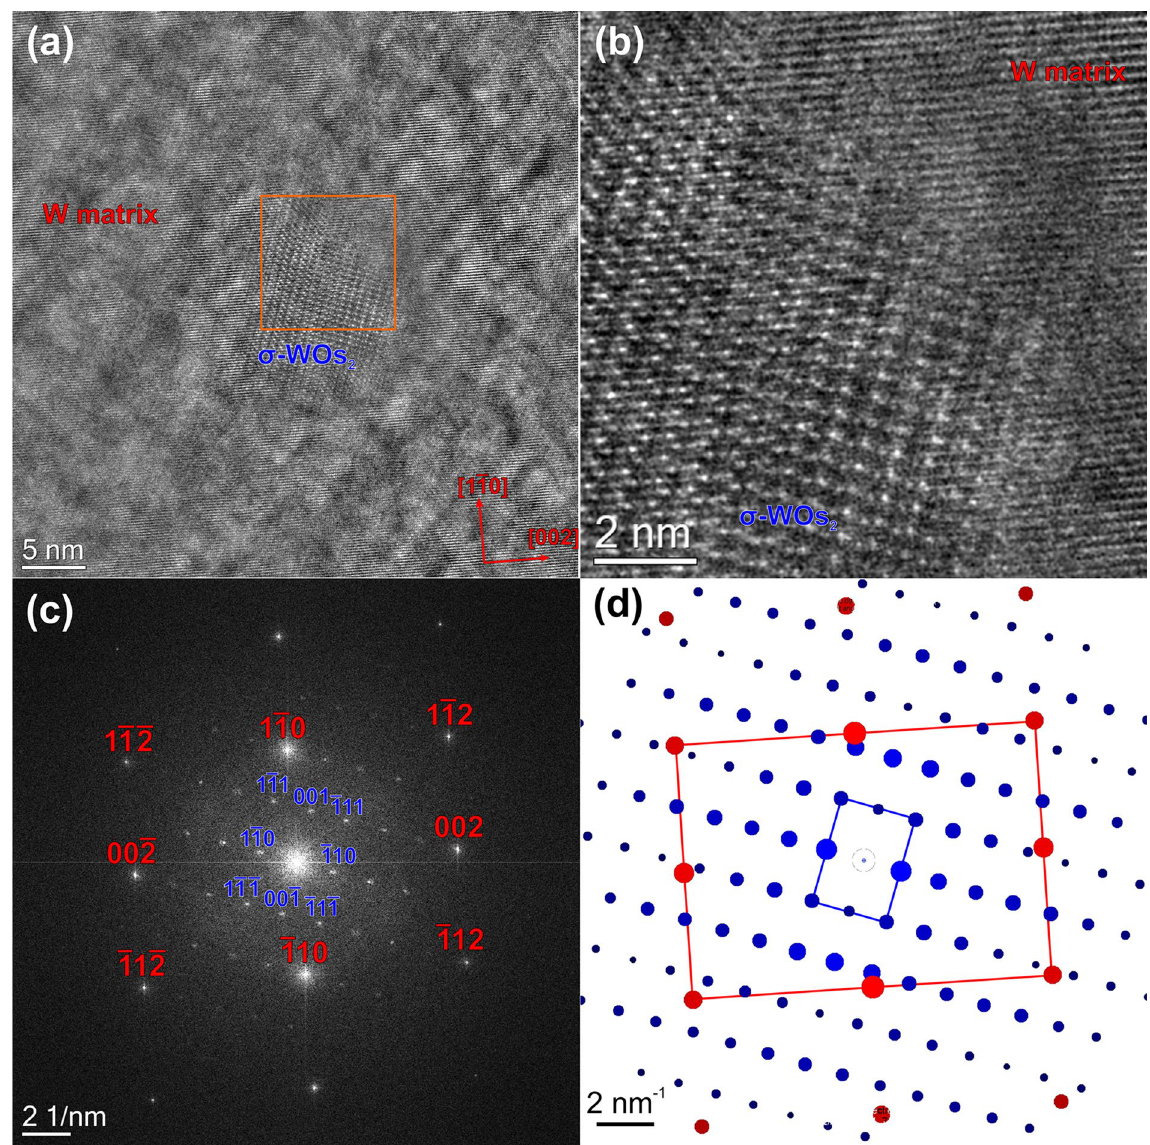
Figure 7. ( a ) High-resolution phase contrast image of a spherical-shaped Os-rich precipitate, which is identified as the WOs 2 σ-phase. Magnified view ( b ) and diffractogram (FFT) ( c ) of the region delimited by the orange square in ( a ). ( d ) Simulated model of the